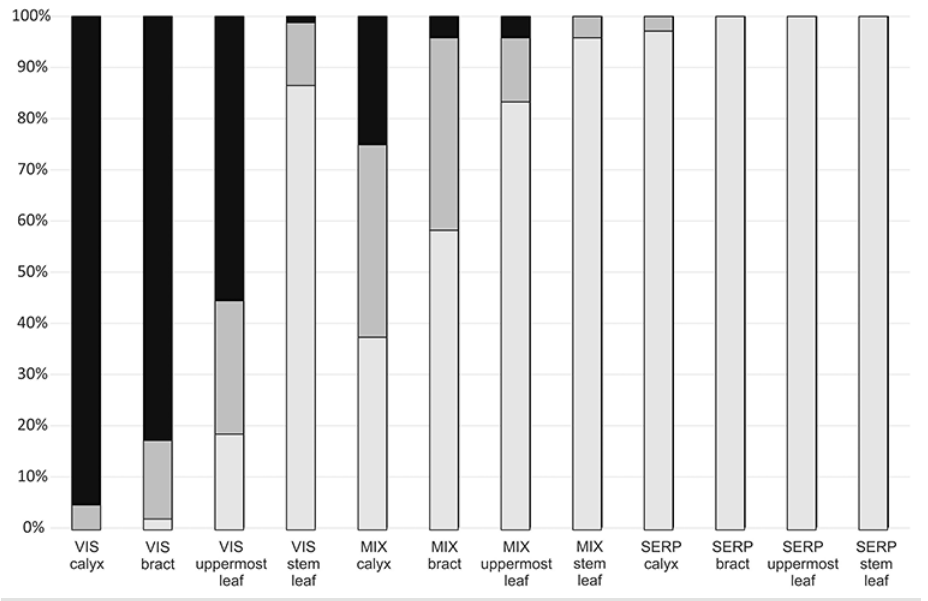
Fig. 2 The share of glandular and eglandular hairs in particular parts of studied specimens represent- ing different plant of predefined morphotypes (i.e., VIS, MIX, SERP); grey – domination of eglandular hairs, dark-grey – mix of eglandular and glandular hairs with equaling proportion; black – domination of glandular